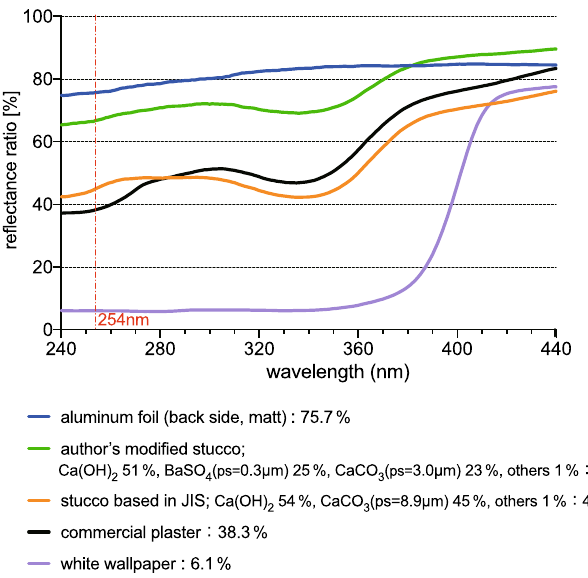
Figure 5. Reflectance ratios of UV lights for various materials and the author’s created